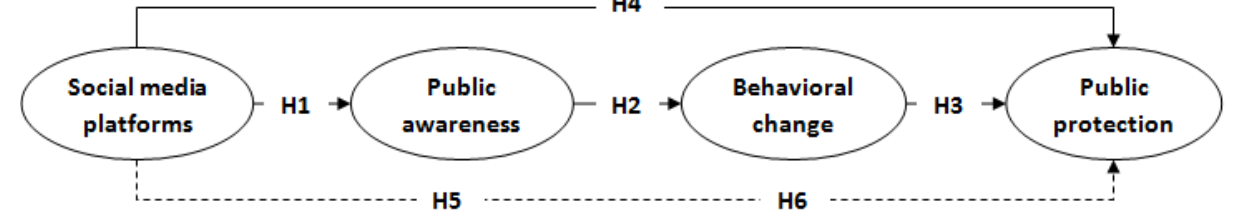
Figure 1. Diagram of the study